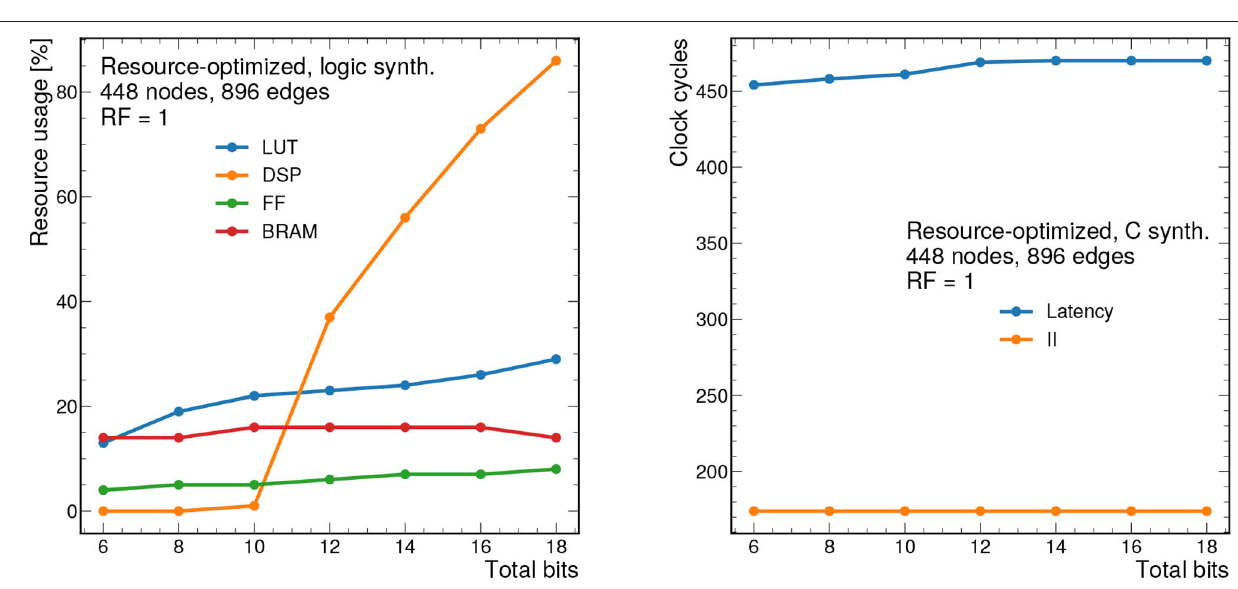
FIGURE 11 | Resource usage estimates as a percentage after logic synthesis (left) and latency and II in clock cycles (right) for a constant reuse factor of 1 as a function of the total bit width for the resource-optimized implementation. Input graphs consist of 448 nodes and 896 edges. Each clock cycle corresponds to